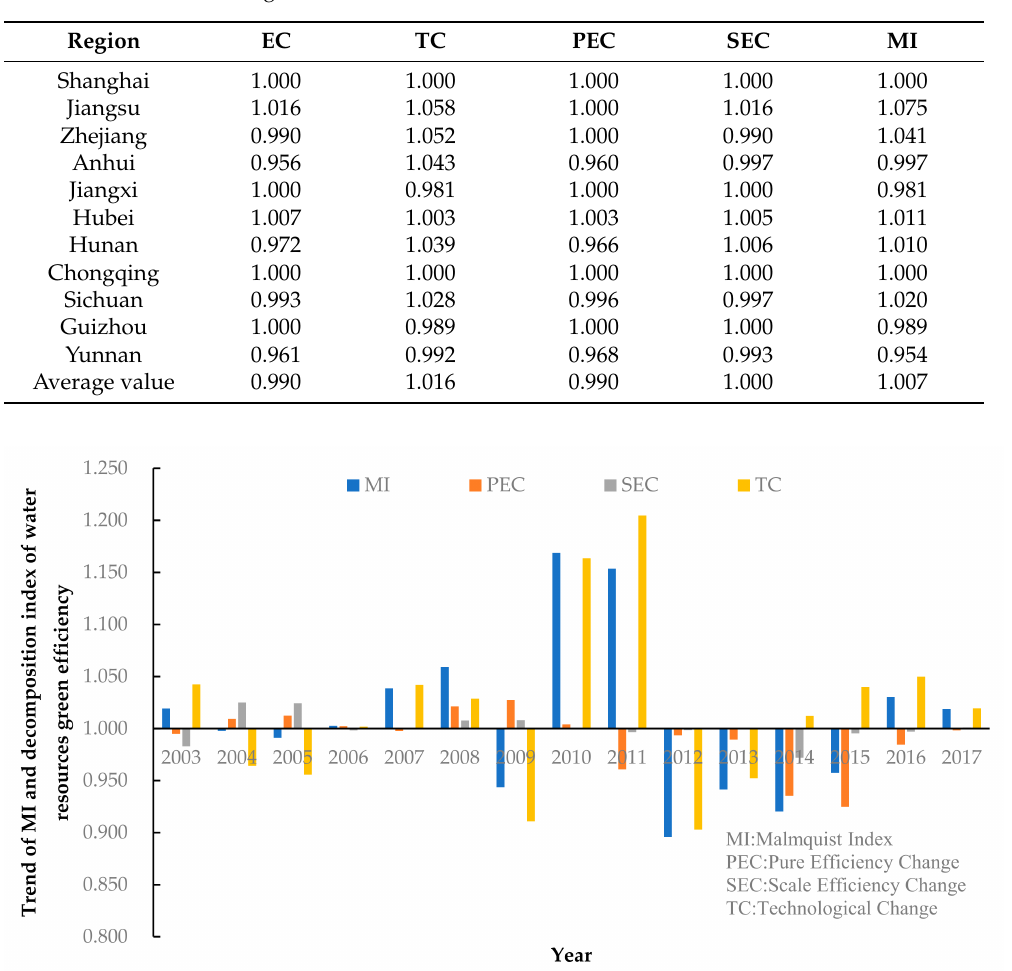
Figure 4. Trend of MI and decomposition index of water resource green efficiency in Yangtze River Economic